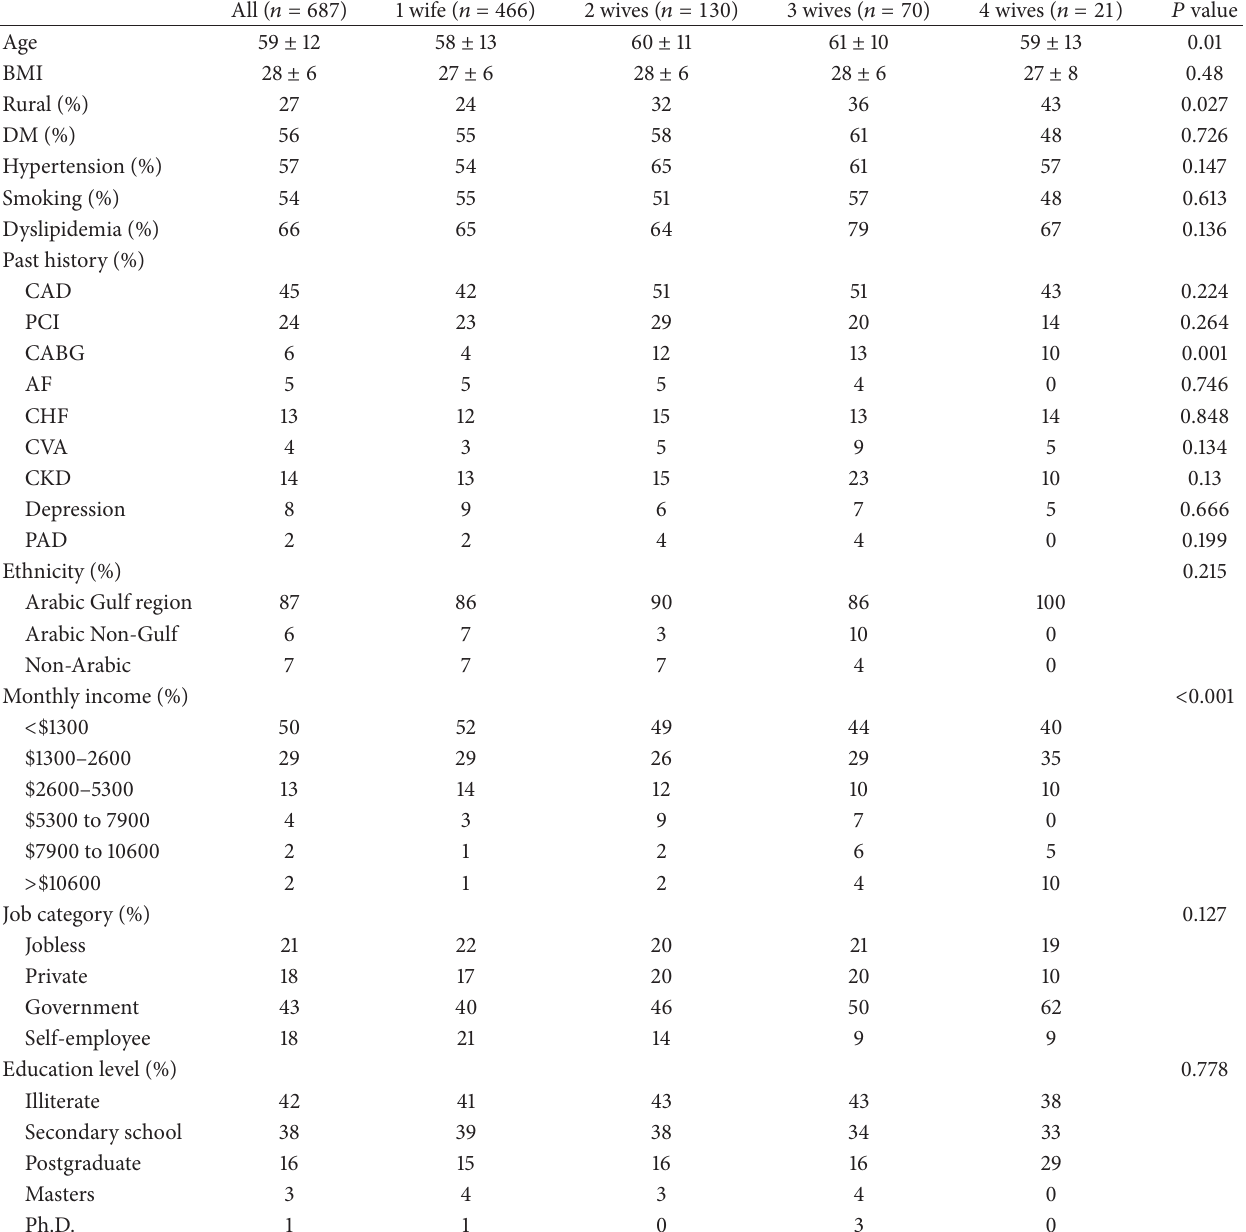
Table 1: Overall patients baseline characteristics stratified by their number of